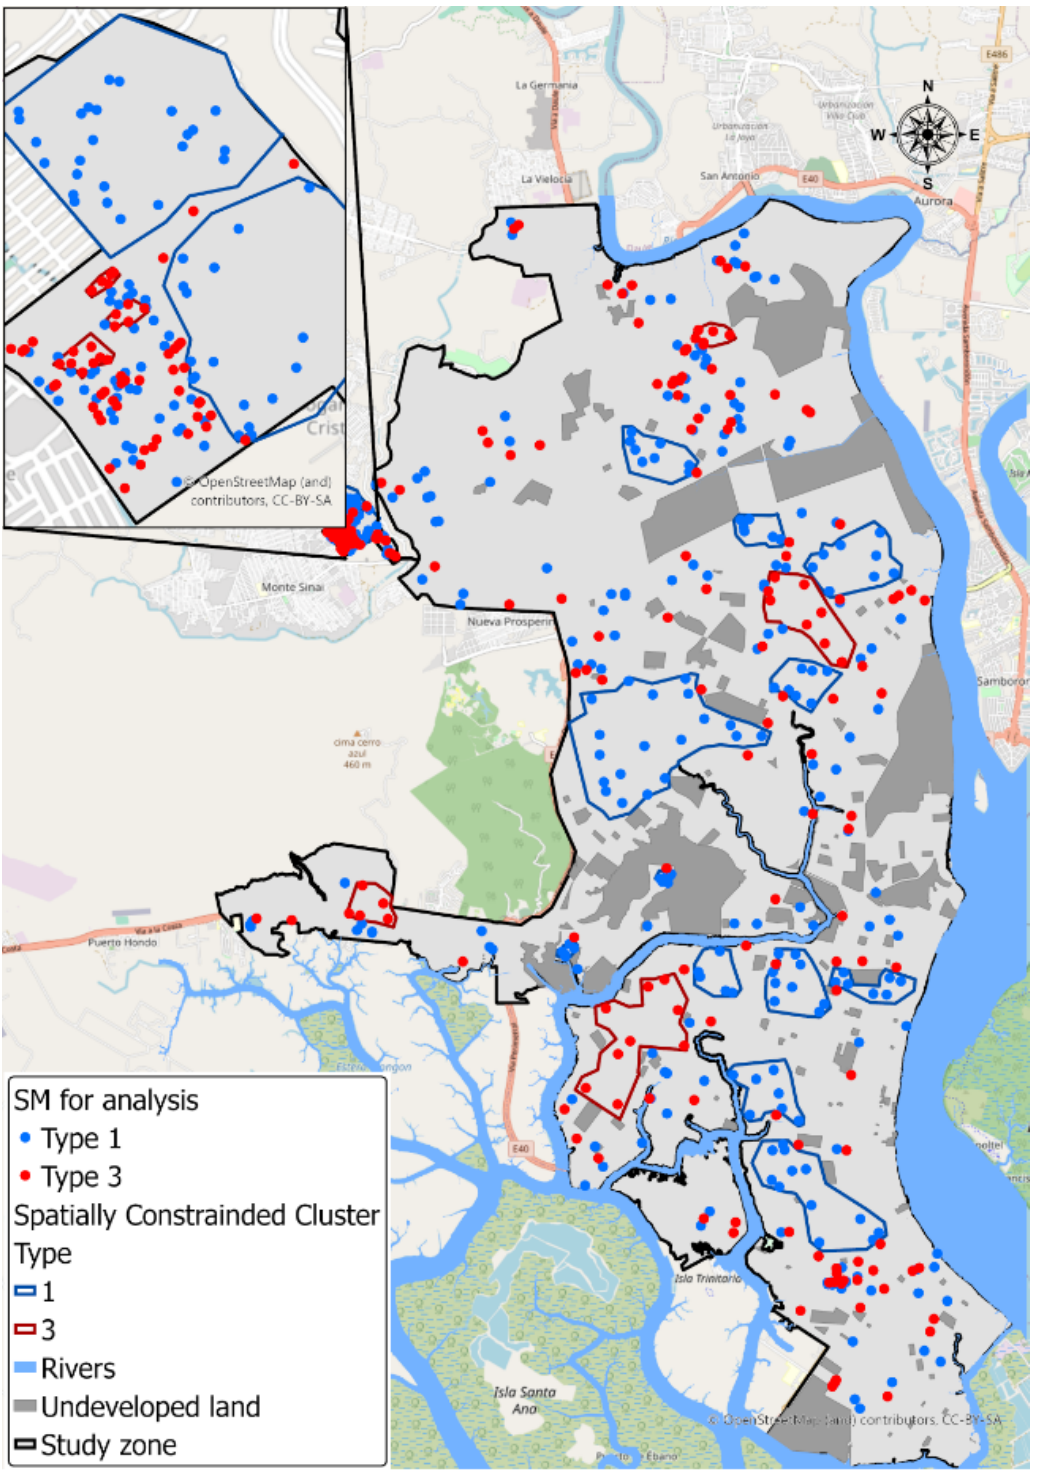
Figure 5. Spatial cluster location map after performing spatially constrained